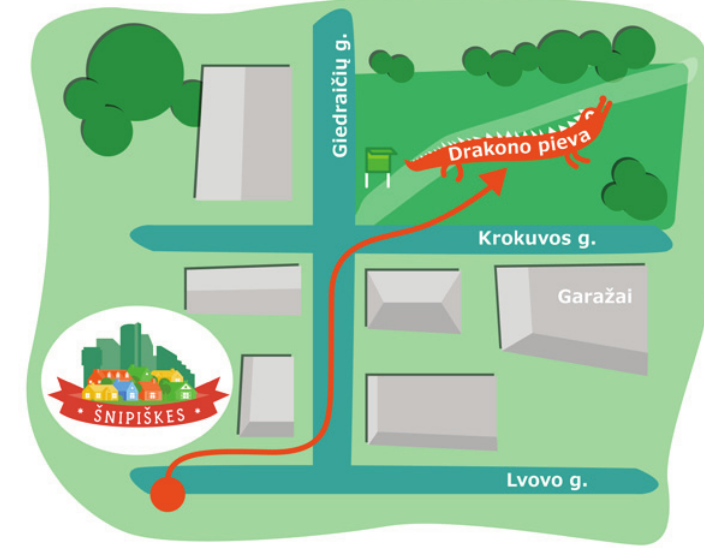
Fig. 2. “Dragon’s field” was one of the alternative names for the anonymous field (municipality’s plot), which was turned into periodical place for gatherings. A detail of Šnipiškės map with a Dragon field, used for flyers, announcing gatherings and events.